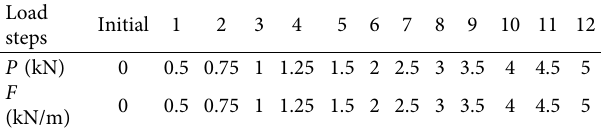
Table 1: Load value.